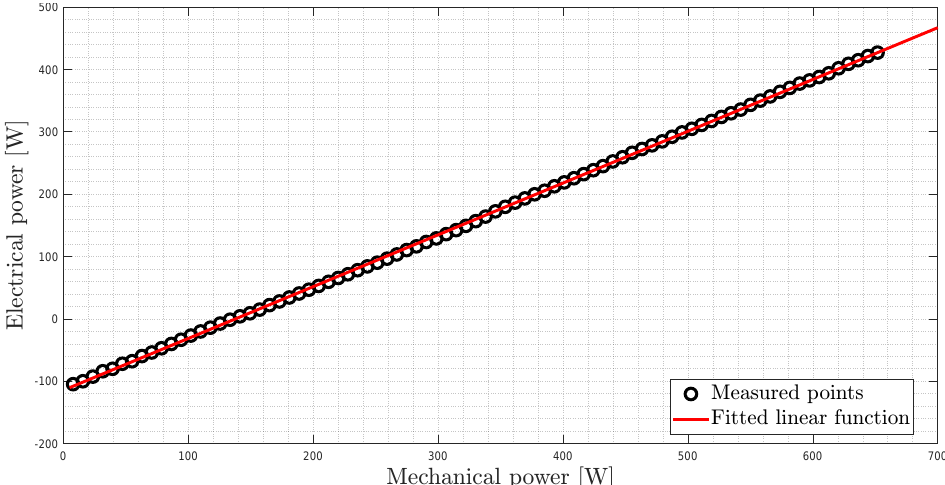
Figure 3. Measurement (circles) of the experiment and the corresponding fitted linear function.